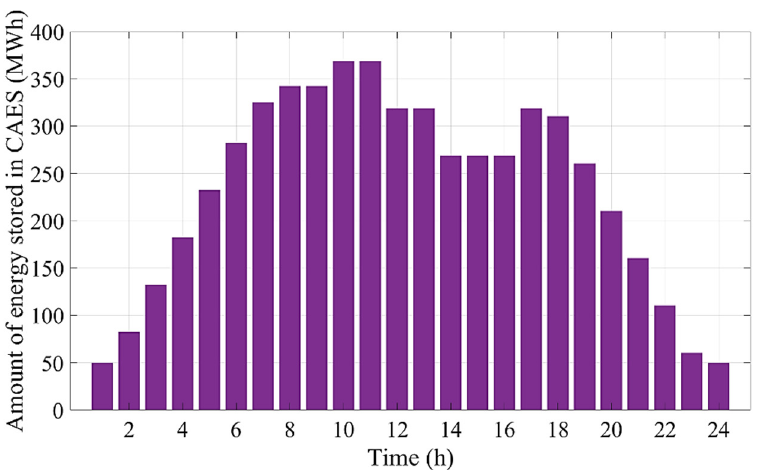
Figure 10. Quantity of energy stored in the CAES in case 2.